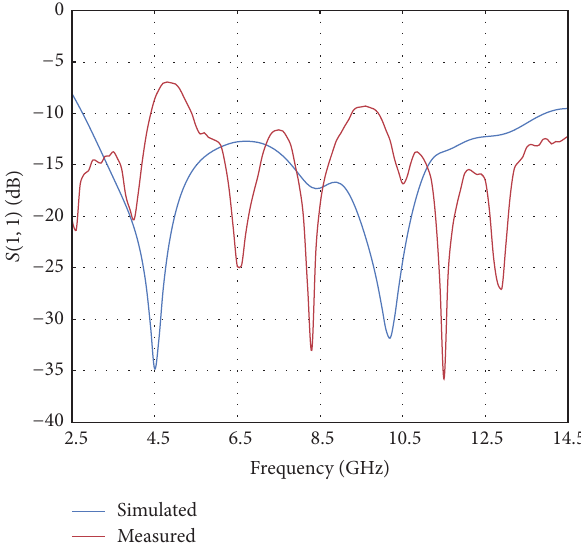
Figure 12: Comparison of simulated and measured reflection coefficients of the UWB